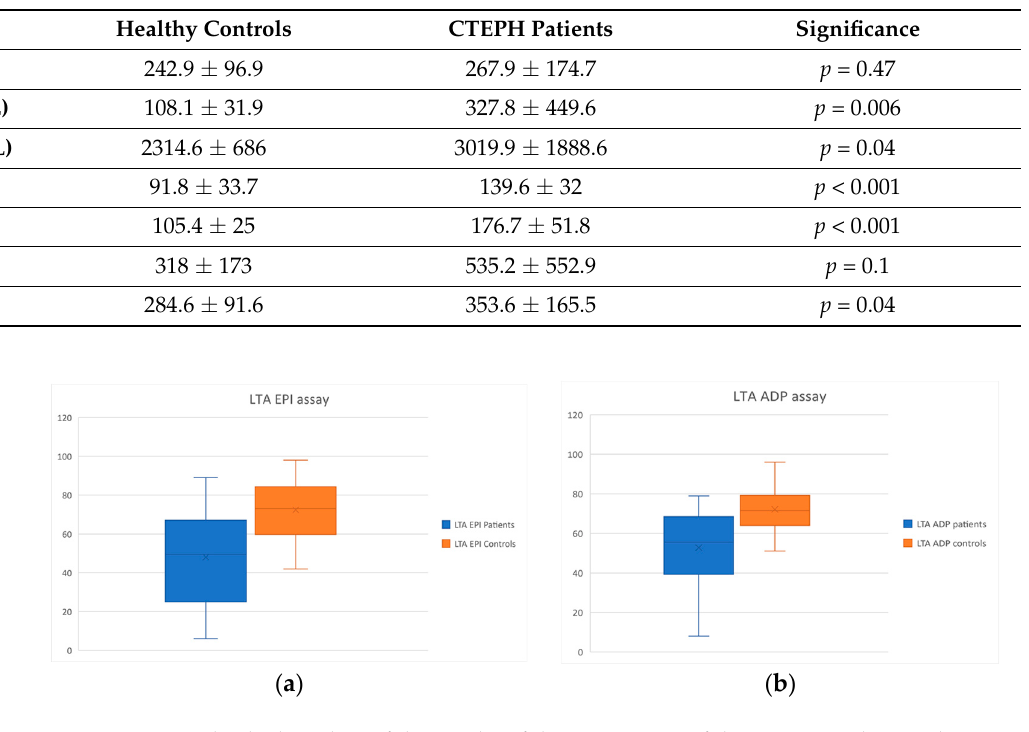
Figure 4. Box and Whisker plots of the results of the LTA assays of the patient and control groups.